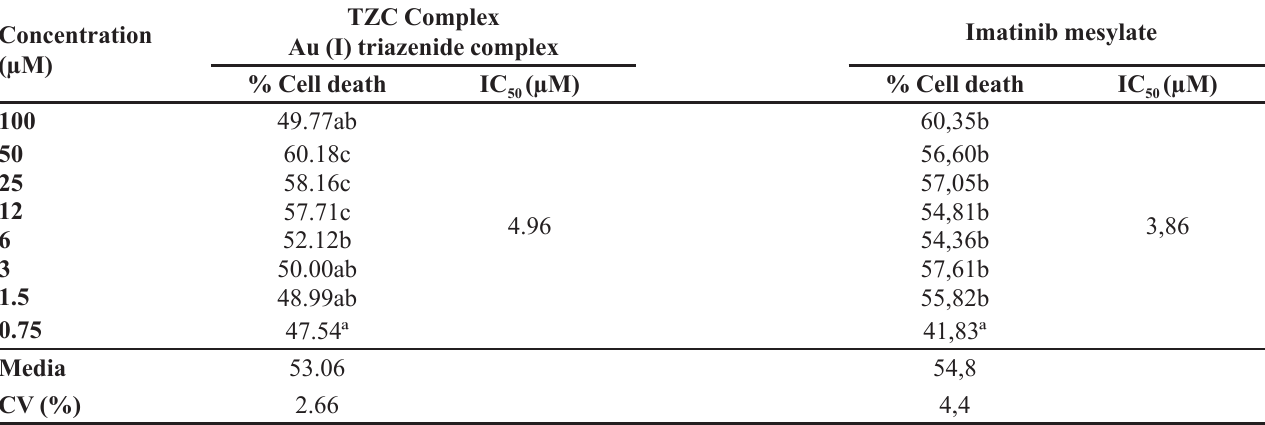
TABLE V – Antiproliferative activity of compound {(1-(2-bromophenyl)-3-(2-nitrophenyl) triazenide] (triphenylphosphine) gold (I)} against K562 cells